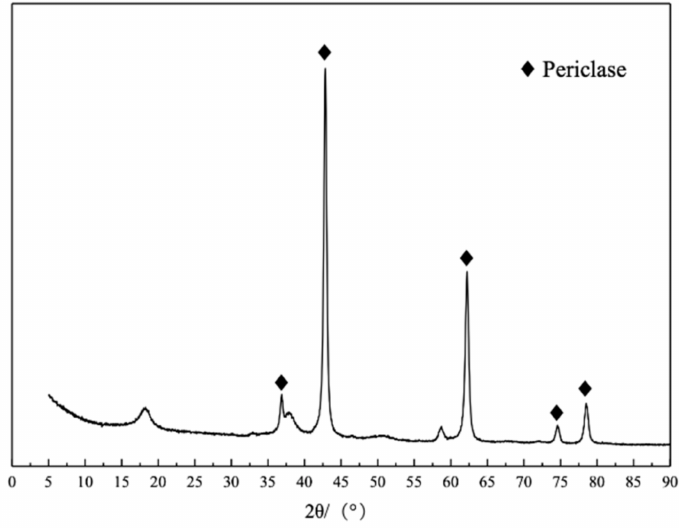
Figure 2. XRD pattern of nano-MgO.